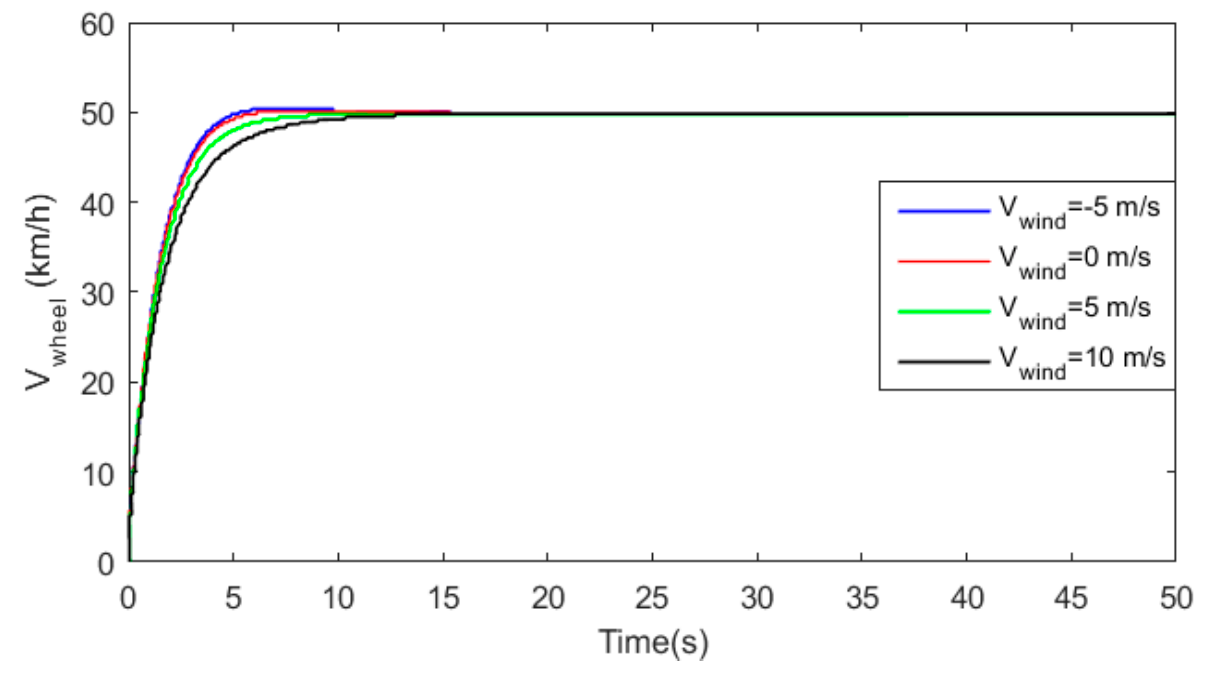
Figure 37. Effect of variation of surface-friction coefficient on BEV speed response.